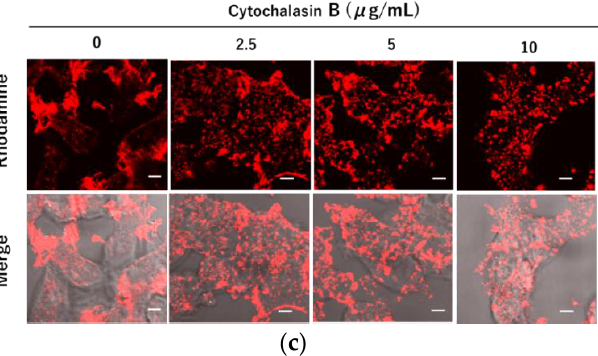
Figure 10. Inhibitory effect of cytochalasin B on internalization of DiD-liposomes bound to the cell surface. HEK293T cells transiently expressing NTCP-GFP were treated with Myr47-Bio+SA followed by DiD-DOPC/PEG-Bio (10%). After being cultured at 37 °C for 3 h in the presence or absence of cytochalasin B at the indicated concentrations, they were subjected to flow cytometry. ( a ) Two-parameter dot plot analyses of cells before and after they were cultured are shown in panels (i) and (ii) or (iii~vi), respectively. Analyses were performed in the absence (i) or presence (ii~vi) of 0.1% trypan blue. To detect cell population endocytosing DiD-liposomes, the gated area in red was set in panel (ii) in which fluorescence of cell surface-bound DiD-liposomes was quenched by trypan blue. The same gated area was applied to (i) and (iii~vi) too. To obtain dot plot data, we analyzed 30,000 cells. ( b ) Quantification of cell population emerging in the gated area after cells were cultured is shown in the bar graph. Cell population endocytosing DiD-liposomes were expressed as percentages which were calculated in this experiment as follows: [cell population in the gated area of the panel (iii~vi) — that of the panel (ii)]/[that of the panel (i) — that of the panel (ii)] × 100. The assay was completed in triplicate and data were expressed as mean ± SD (vertical bars). ** p < 0.01 in Student’s t -test. ( c ) Actin staining of HEK293T cells treated with cytochalasin B. To examine the effect of cytochalasin B on actin filament formation in HEK293T cells, they were cultured on the poly-L-lysine-coated cover glass. Treatment of cytochalasin B was performed at the same doses (2.5, 5, and 10 μ g/mL) as those used in the experiments of panels ( a , b ) for 3 h. Actin was stained using rhodamine phalloidin. Rhodamine: rhodamine fluorescence is shown in red; Merge: rhodamine fluorescence and bright field images are merged. Bars indicate 5 μ m.